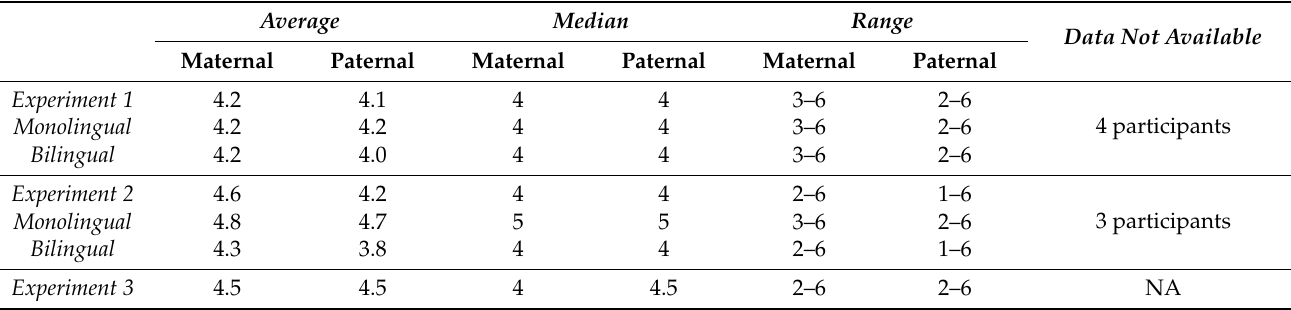
Table 1. Maternal and paternal education levels for participants for all three experiments. Parents indicated which of the following options best described their highest level of education: (1) below high school, (2) high school, (3) some college or certification, (4) Bachelor’s degree, (5) Master’s degree, (6) professional degree (e.g., PhD, MD). We report the average, median, and range.